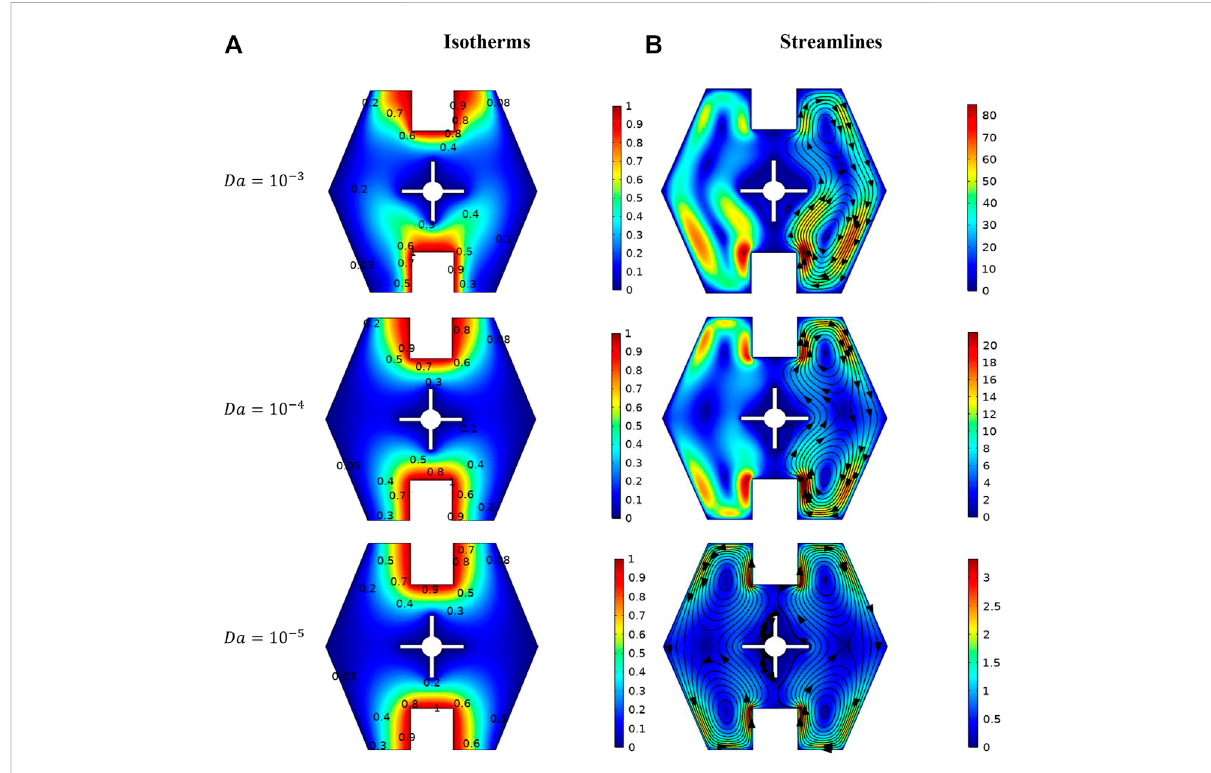
FIGURE 4 (A,B) Isotherms (left) and streamlines (right) under the in fl uence of Da at Ra (cid:2) 10 3 and Pr (cid:2) 0 .